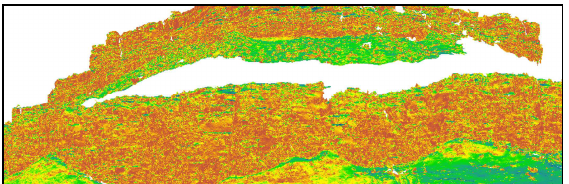
Figure 7. Slope-encoded image that can be used as a processing mask in remote sensing software. White areas are outside of the 3D model. Garley Canyon image used (Fig.